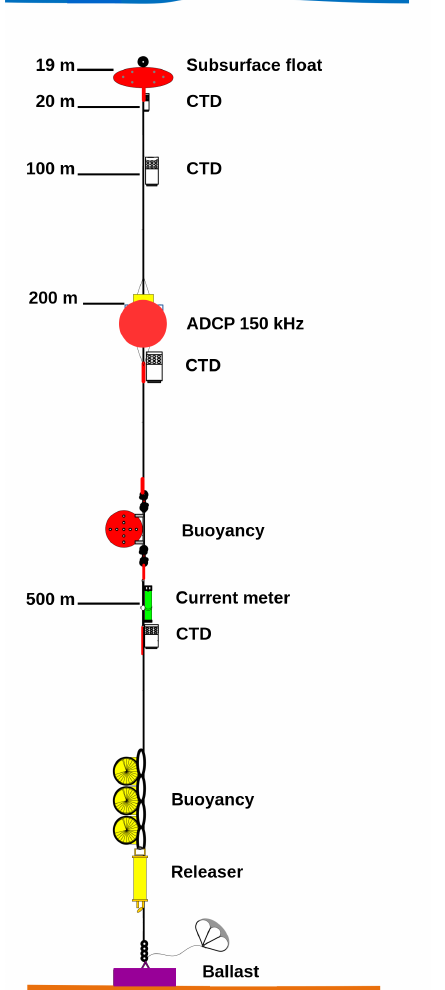
Figure 4. Design drawing of mooring M3. For explanations, see text.